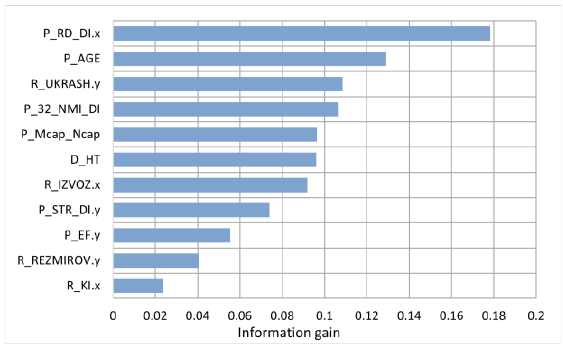
Figure 4. Information gain of variables of the final model.